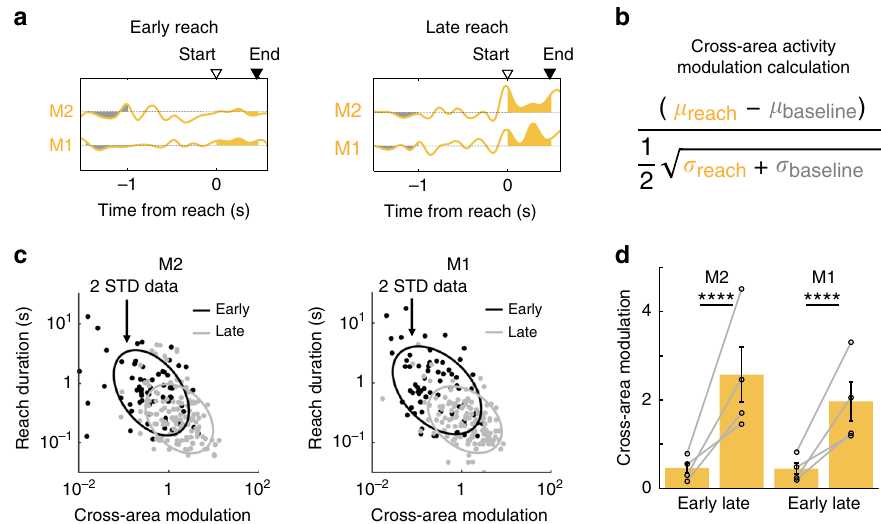
Fig. 5 Learning ampli fi es cross-area representations of reach duration. a Example single-trial M2 and M1 cross-area activity in early (left) and late (right) learning. Reach duration is indicated by triangles marking reach start (open triangle) and reach end ( fi lled triangle). Single-trial baseline modulation in gray, reach modulation in yellow. b Equation for calculating cross-area activity (CA) modulation (see Methods). c Single-trial CA-modulation predicts single-trial reach duration. Single-trial CA-modulation for M2 (left) and M1 (right) cross-area activity is plotted against single-trial reach duration. Points show randomly subselected trials from early (black) and late learning (gray), with ellipses fi tted to 2 standard deviations of the full datasets. All trials were used for quanti fi cation. d CA-modulation increases in both M1 and M2 with learning. Gray lines, also marked by black open circles, show values for individual animals, bars show mean ± std. dev., n = 4 rats. **** p < 0.0001. one-sided hierarchical bootstraps, not adjusted for multiple